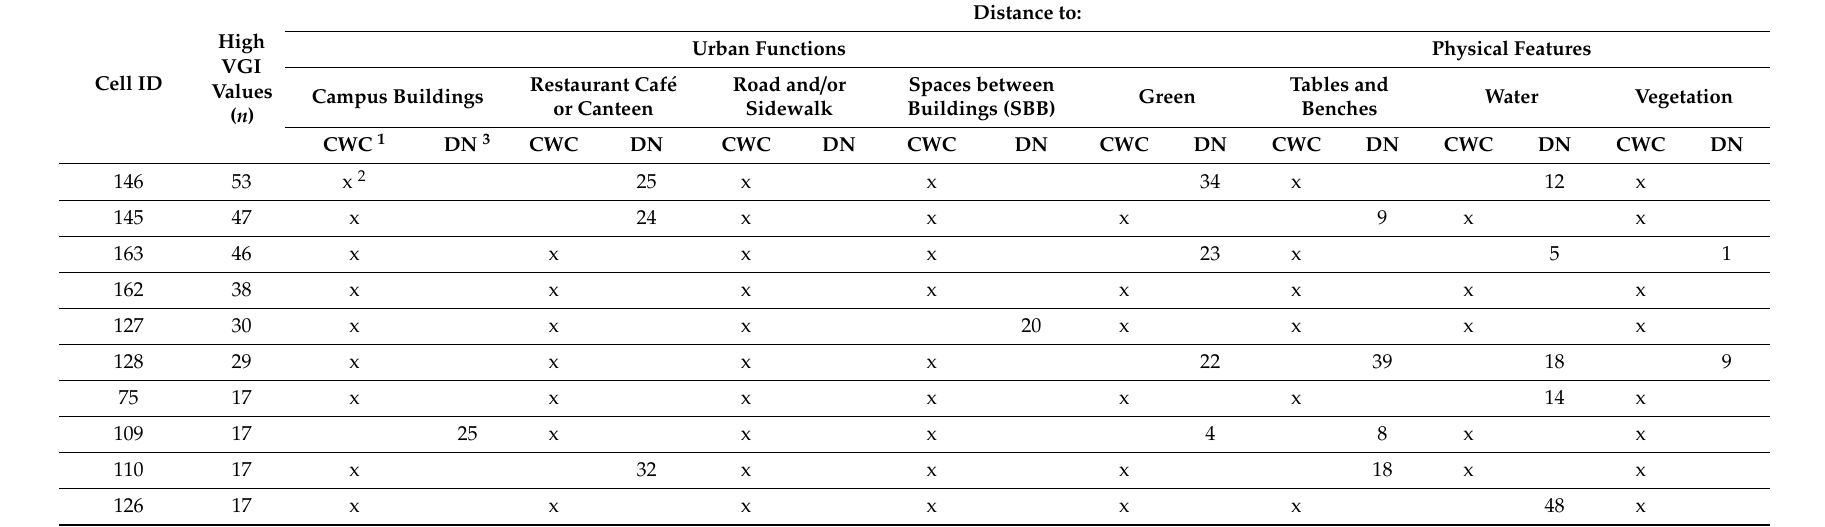
Table 8. Distances between VGI data and built-environment features at UU inner-city